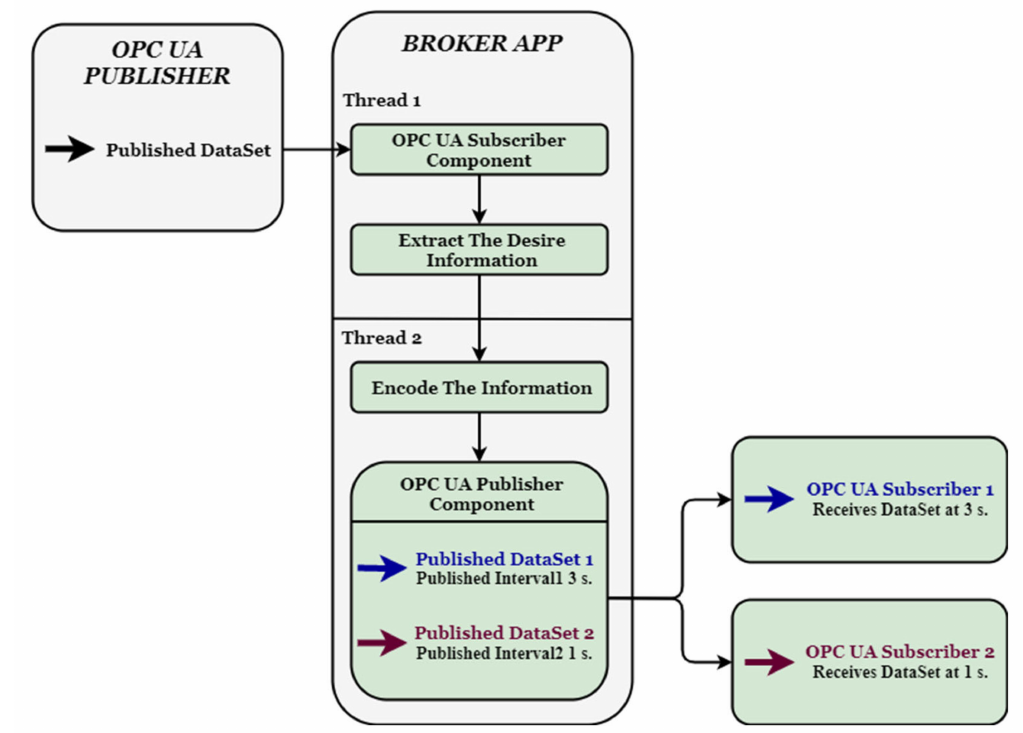
Figure 4. Architecture and Interaction of the Broker